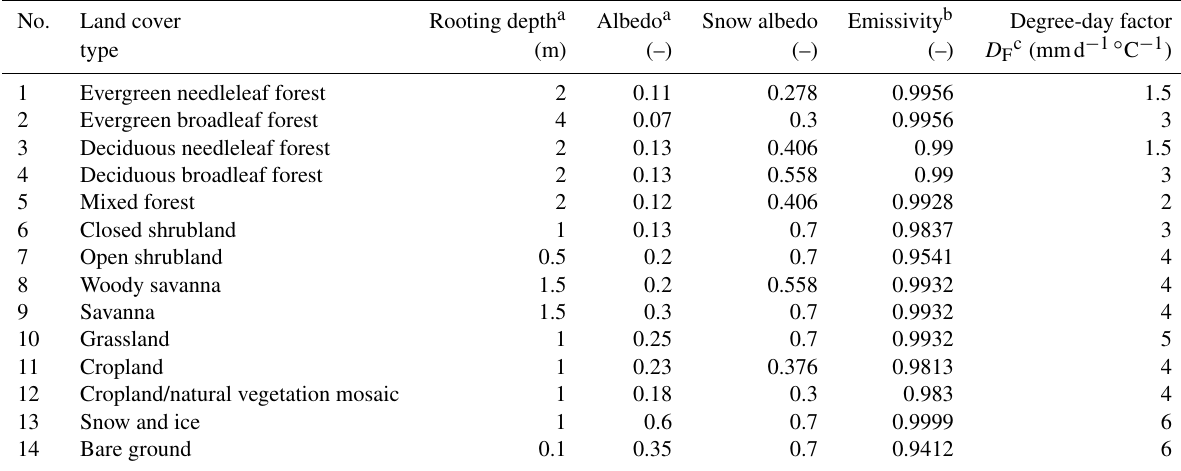
Table C2. Attributes for IGBP land cover classes used in WaterGAP 2.2d from Müller Schmied et al. (2014). Water has an albedo of 0.08, snow